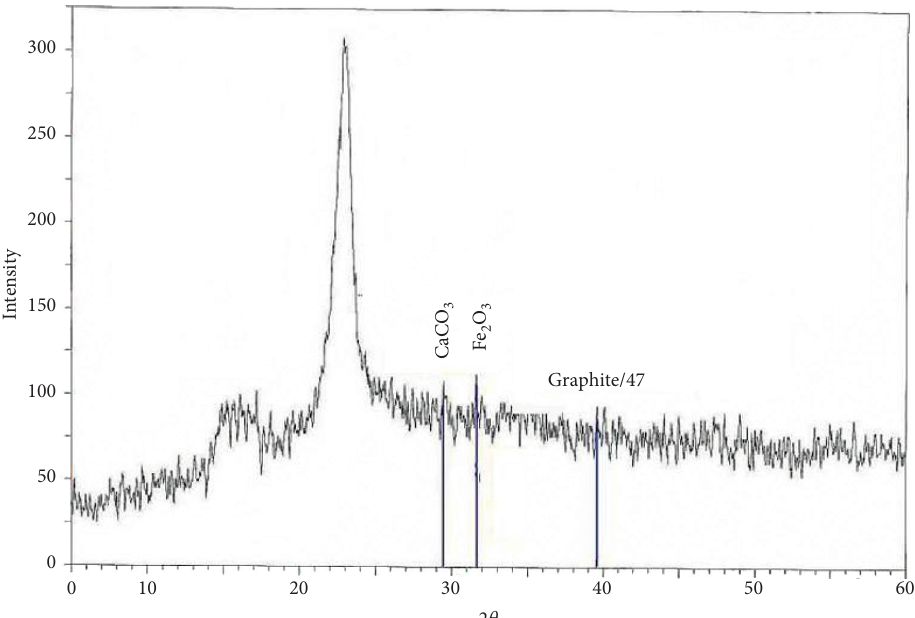
Figure 6: XRD pattern of ink confirmed that ink composed the graphite particles.